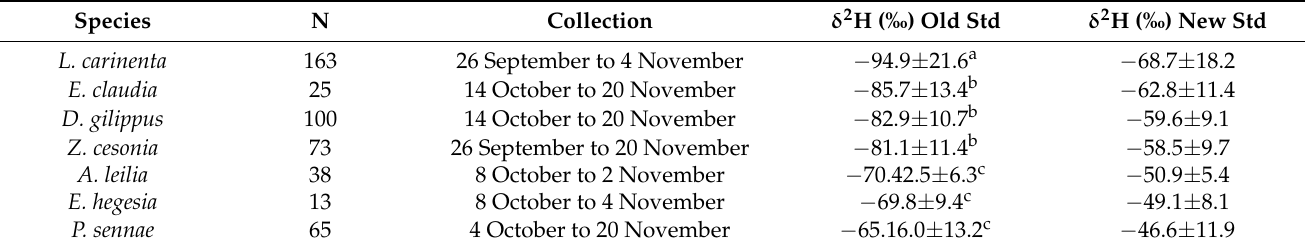
Table 1. Summary of wing stable hydrogen isotope ( δ 2 H) (mean ± SD, Vienna Standard Mean Ocean Water (VSMOW) ‰) for 7 species of road-killed butterflies moving through a migratory bottleneck highway crossing near Monterrey, Mexico in 2019. Superscript letters are the results of a Tukey post-hoc analysis whereby similar letters indicate no significant difference ( p < 0.05). Wing δ 2 H values calibrated to old values (EC-01 = − 197‰, EC-02 = − 54.1‰) and new values (EC-01 = − 157‰, EC-02 = − 35.3‰) are